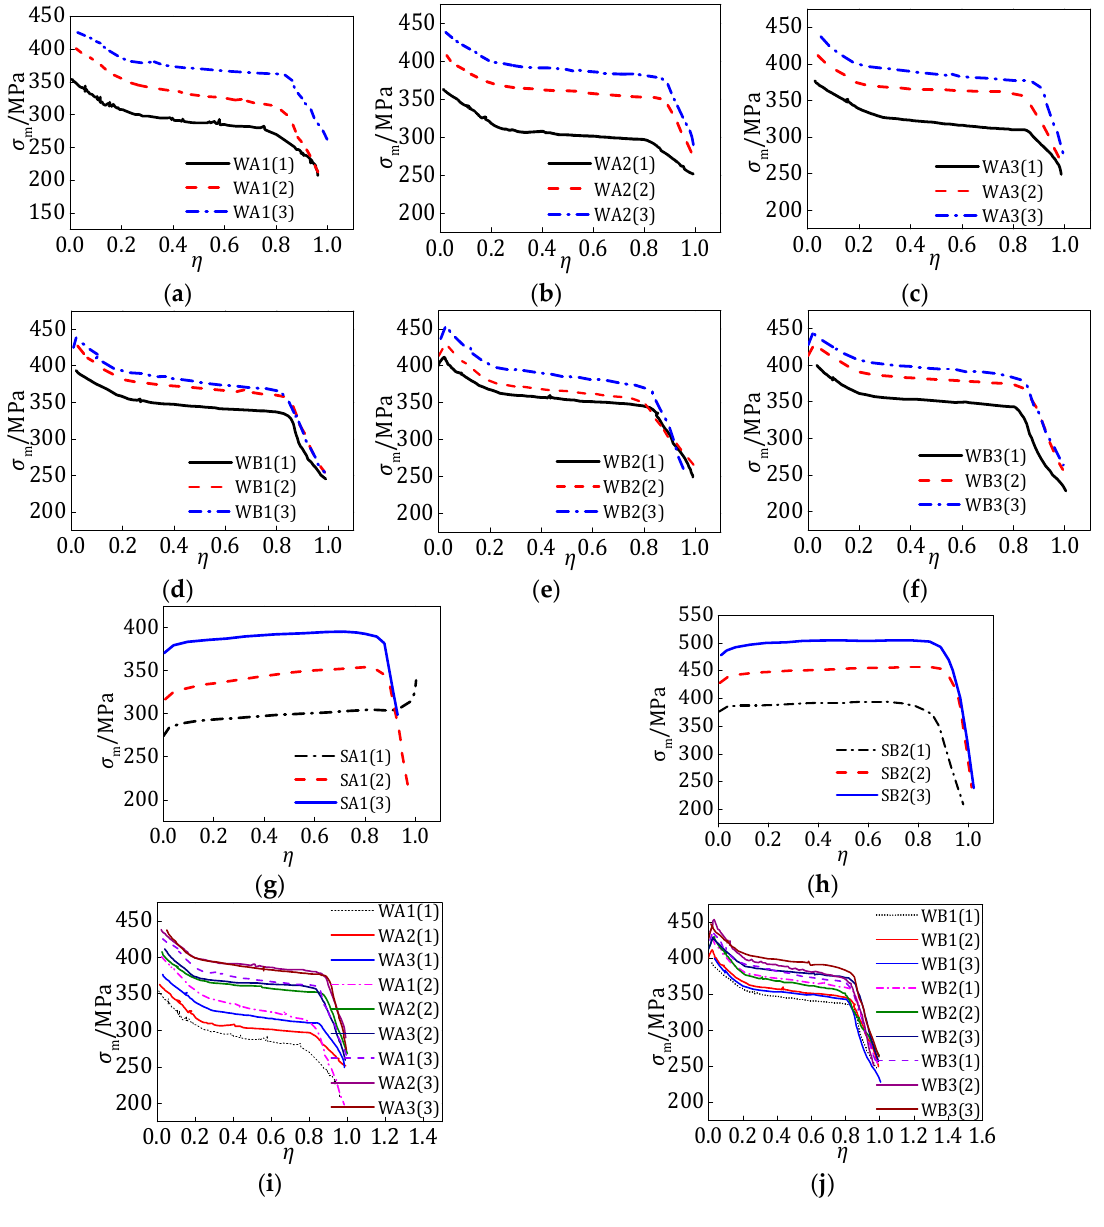
Figure 8. Stress amplitude-dimensionless ( σ m - η ) half cycle of welding material and steel. ( a ) WA1; ( b ) WA2; ( c ) WA3; ( d ) WB1; ( e ) WB2; ( f ) WB3; ( g ) WA; ( h ) WB; ( i ) SA1; ( j ) SB2.